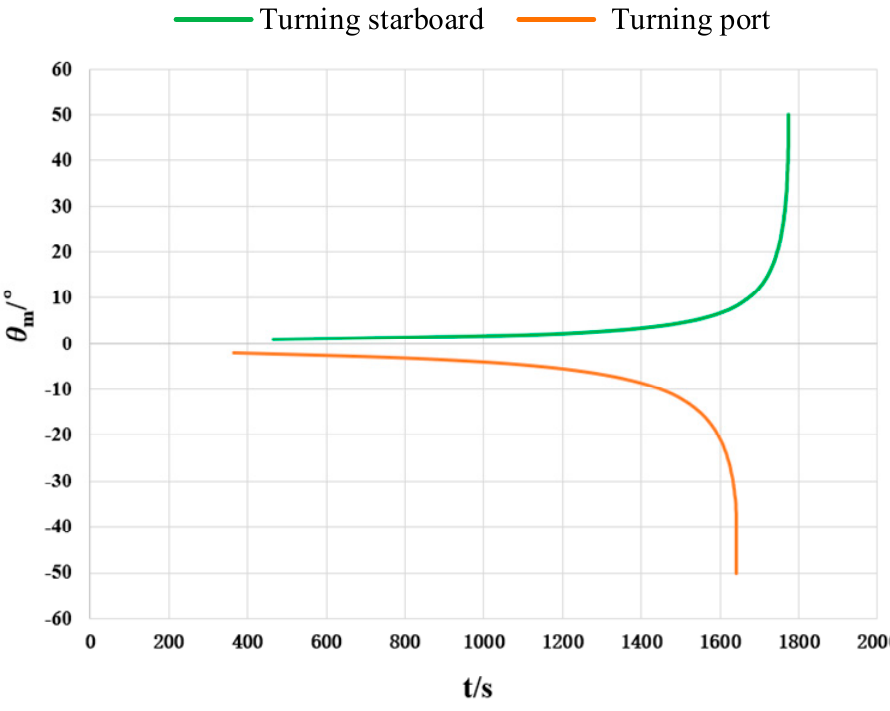
Figure 13. Minimum course alteration angle under different times when the collision domain is not violated.